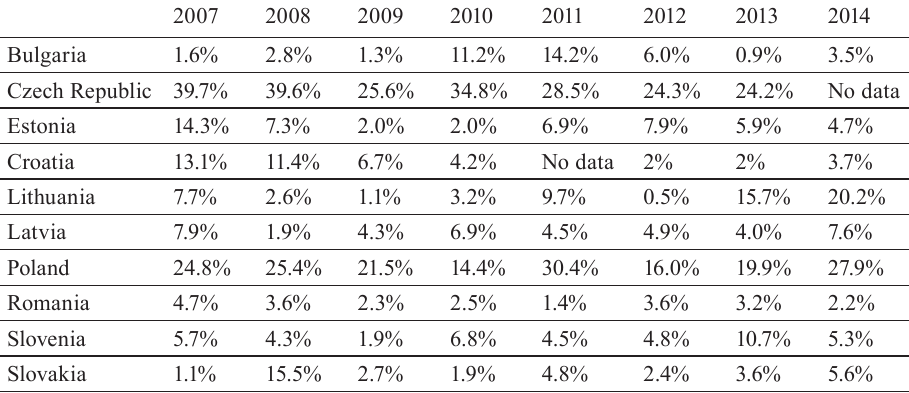
table 1. National film production market share, including